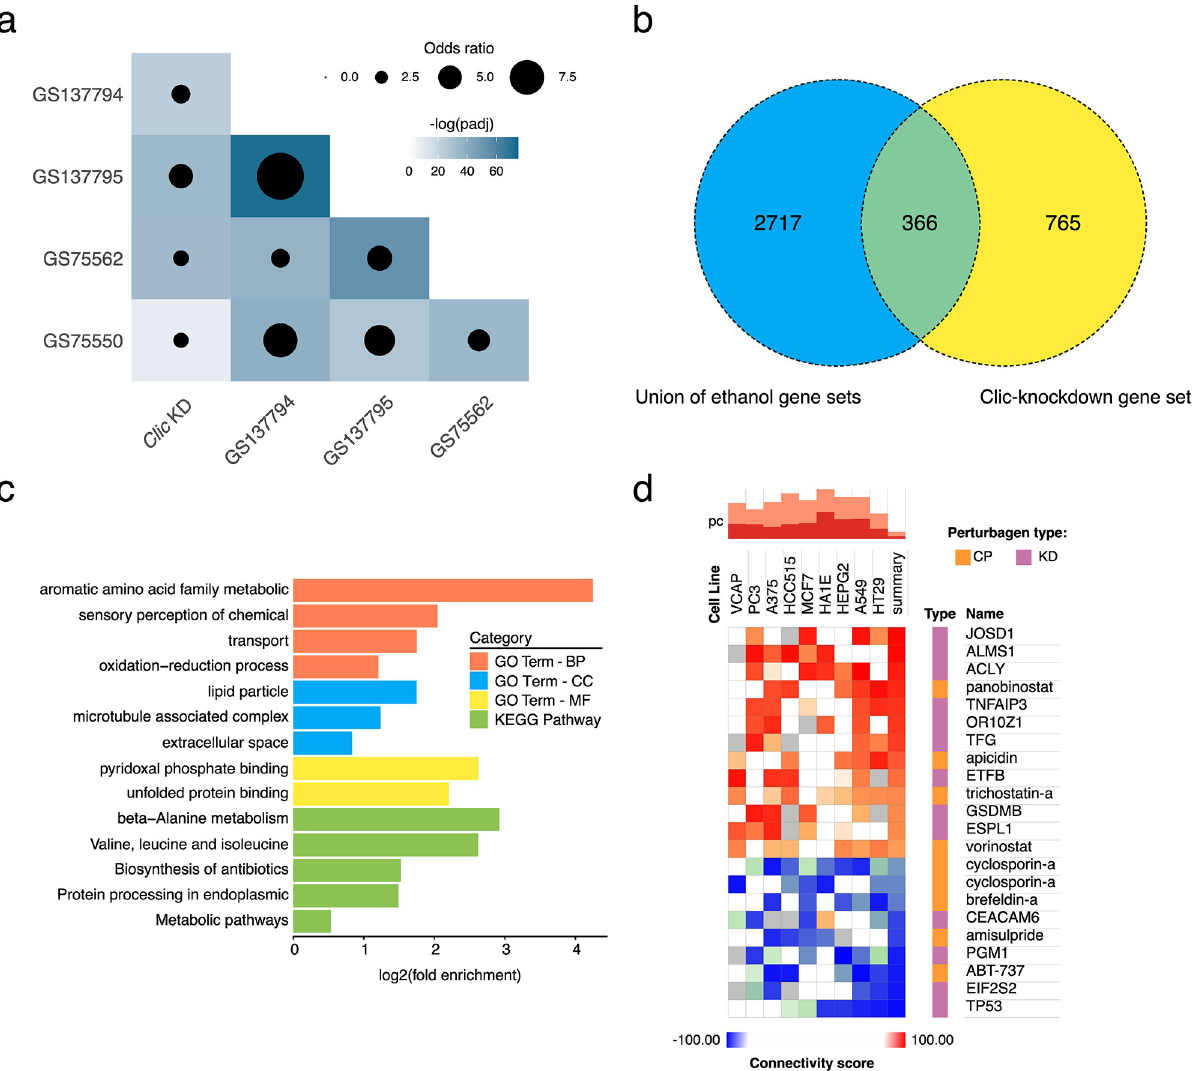
Fig 4. Gene sets overlapping with Clic knockdown. (a) Heatmap displaying similarity between Clic knockdown-sensitive genes and the 4 Drosophila ethanol-related gene sets obtained through GeneWeaver. Color scale indicates the negative log 10 of the Bonferroni adjusted p-value obtained from Fisher’s exact testing and bubble radius indicates size of odds ratio for gene set overlap being significantly larger than expected by chance. Genes shared between the union of the 4 ethanol-related gene sets and the Clic knockdown-responsive gene set shown in (b) along with their GO functional enrichment analysis (c). (d) CMap analysis of perturbagen transcriptomic signatures with high positive (red, tau > 90) and negative (blue, tau < 90) connectivity with the Clic knockdown transcriptomic signature among 9 human cell lines. Assayed perturbagens include compounds (CP) and gene knockdowns